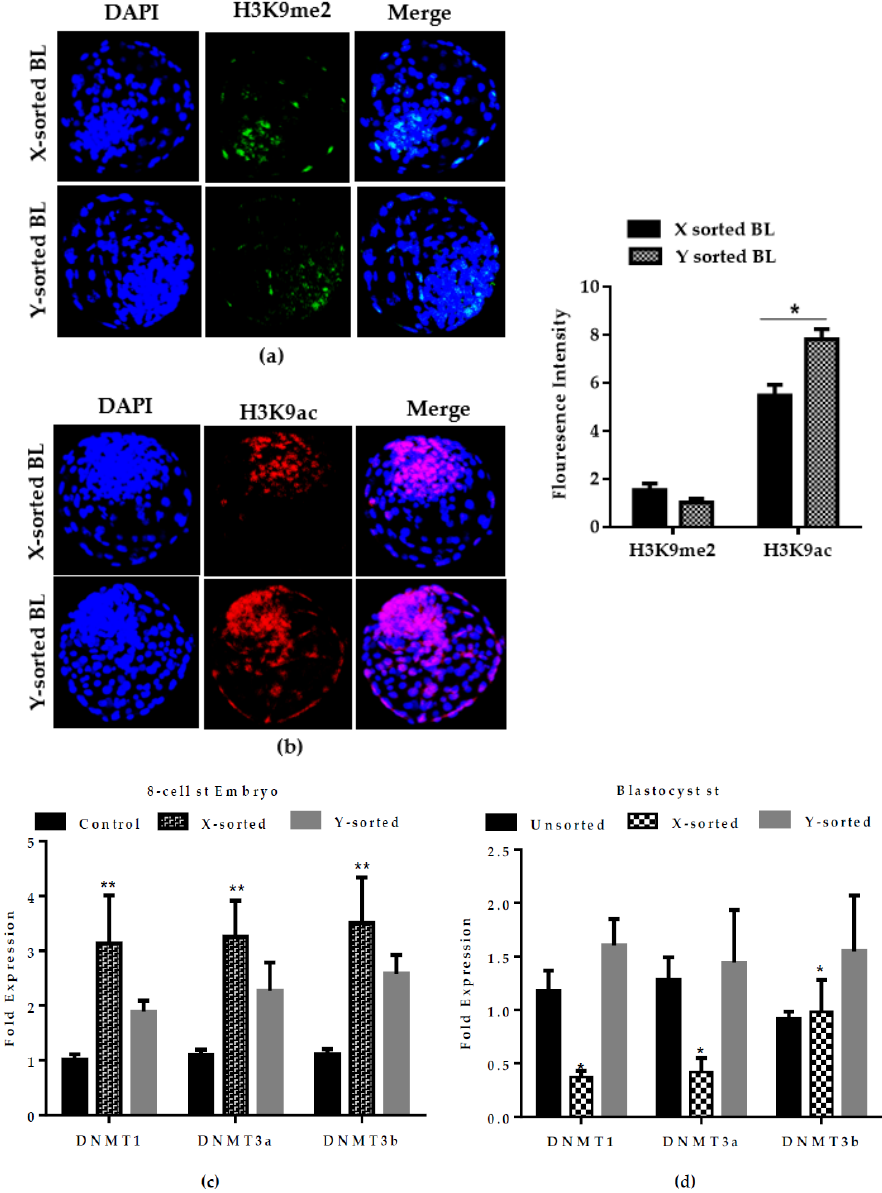
Figure 6. Epigenetic status during development of X and Y sperm-sorted BL. ( a ) Representative fluorescent images of H3K9me2 and ( b ) H3K9ac in X- and Y-BL. Mean fluorescence intensity of H3K9me2 and H3K9ac signals in the X- and Y-BL groups are presented in the graph. The experiment was performed in triplicate sets of experiment with 20 BLs per group in each replicate ( c,d). Analysis of relative mRNA expression of DNMTs in X and Y sperm-sorted 8-cell stage embryo and day eight BLs. Data in the bar graphs represent the means ± SEM from three independent sets of experiments. * p < 0.05; ** p < 0.01. Original magnification 100 ×